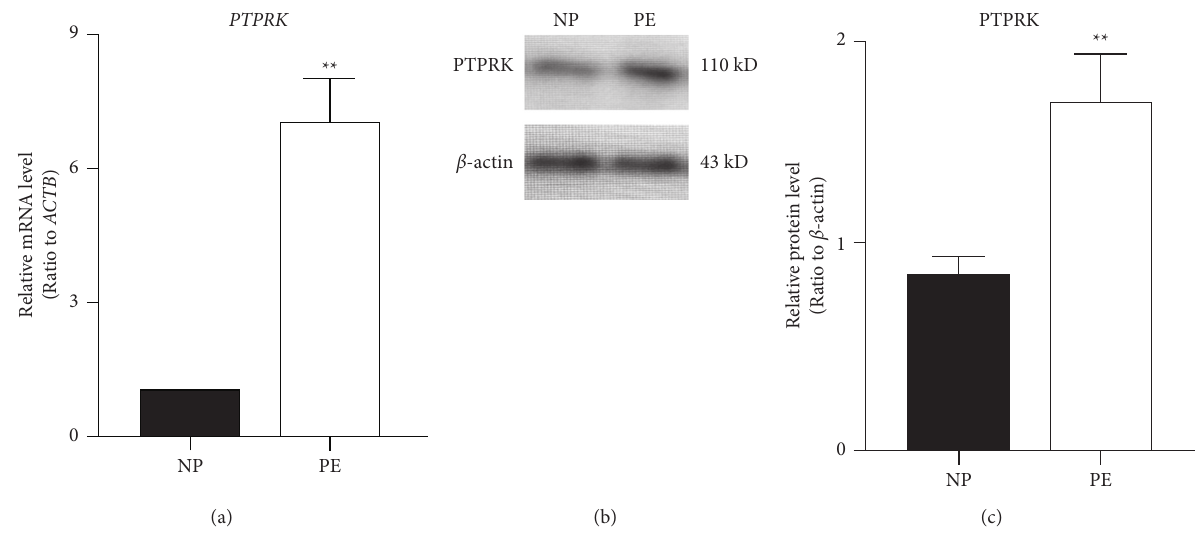
Figure 2: Expression patterns of PTPRK in human placentas. (a) QPCR analysis for PTPRK mRNA levels. The mRNA expression was determined using the 2 − ΔΔ Ct method with ACTB for normalization and was then compared to the control group ( n � 20). (b, c) Western blotting analysis for the PTPRK protein levels (100 μ g of each placental sample) in human placentas from normal pregnancies (NP) and preeclamptic (PE) pregnancies. Representative blots are shown in (b), and the quantitative result is presented in (c). Data are expressed as mean ± SD of three independent experiments. ∗∗ P < 0 .